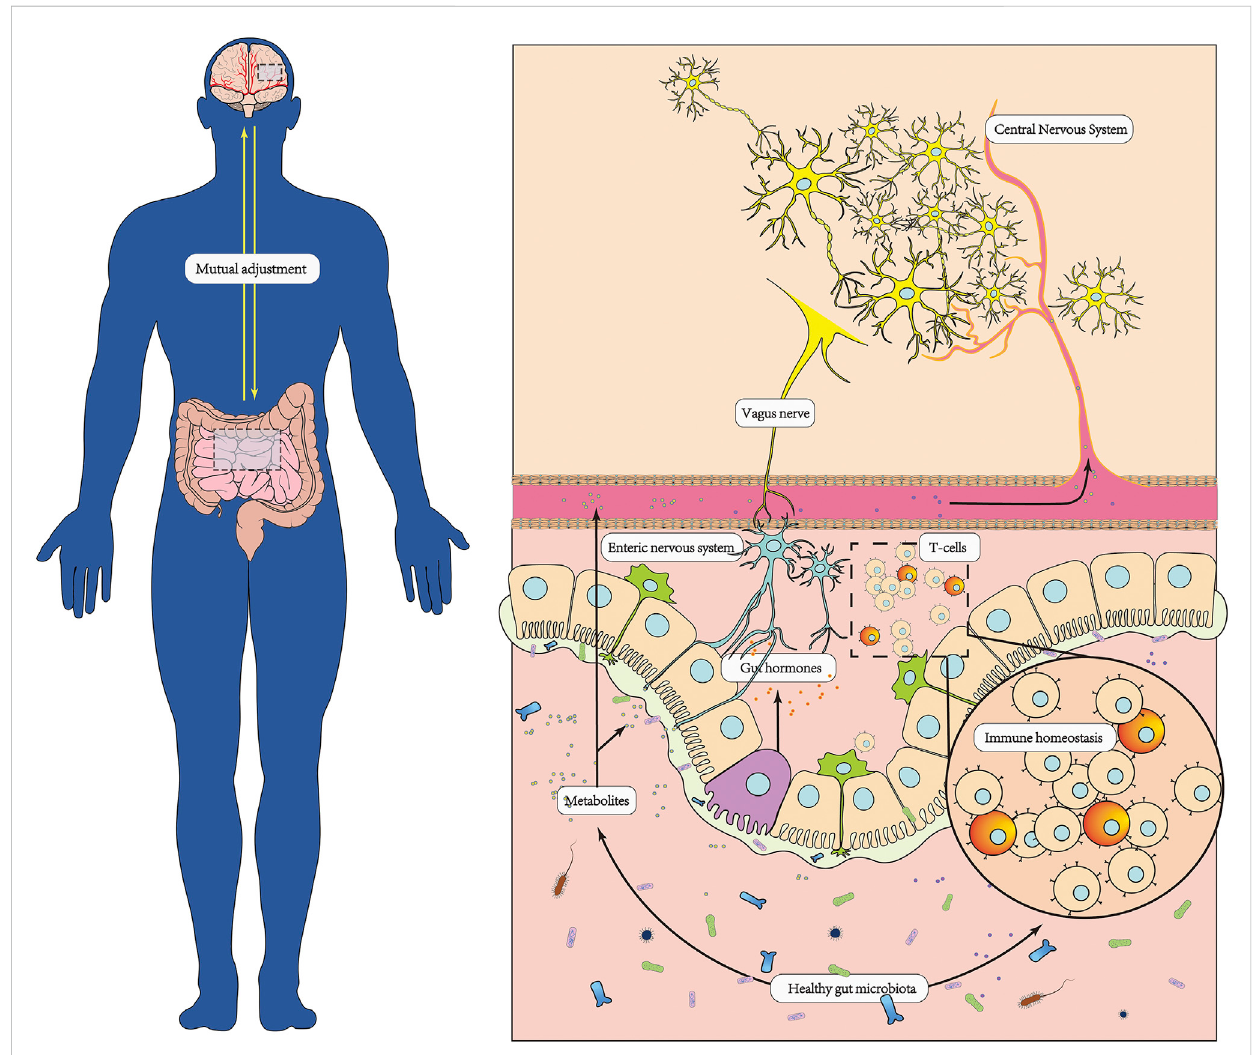
FIGURE 1 In healthy conditions, the brain and the gut microbiota have bidirectional regulation. The brain regulates the function of the gut through multiple neurological, endocrine and immune pathways, providing a stable and healthy environment for the colonization of the gut microbiota. Meanwhile, the gut microbiota plays an important role in facilitating the conversion and absorption of nutrients, maintaining homeostasis of the enteric and organic immune systems, protecting the integrity of the intestinal mucosal barrier, and promoting the development of the nervous